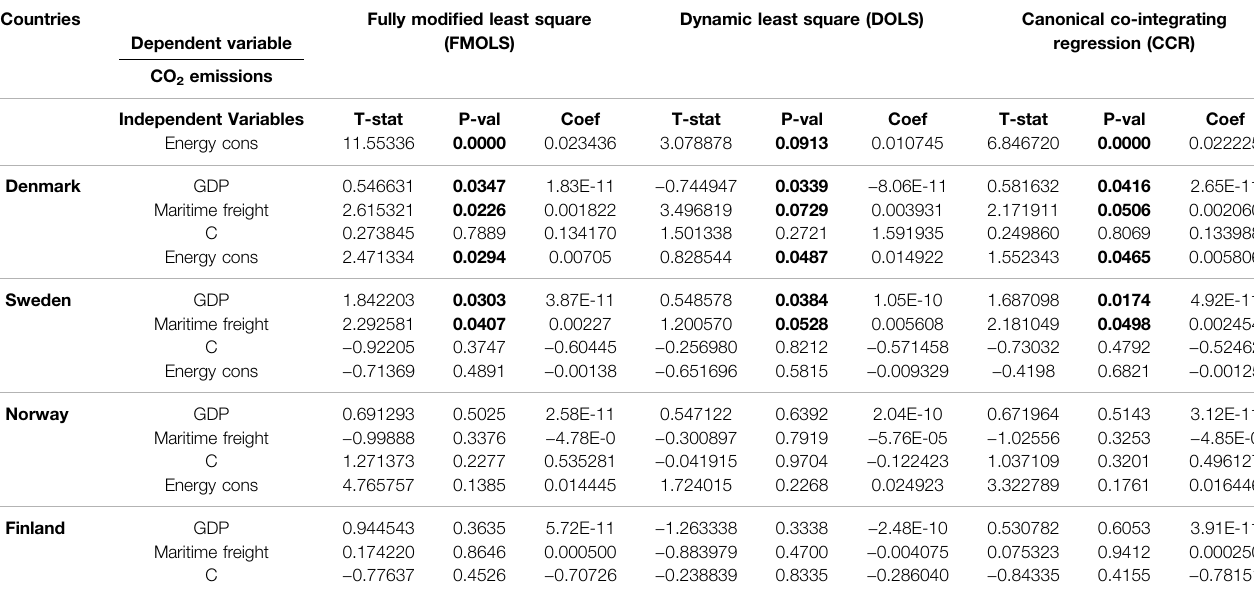
The bold values indicate the existance of the co-integration